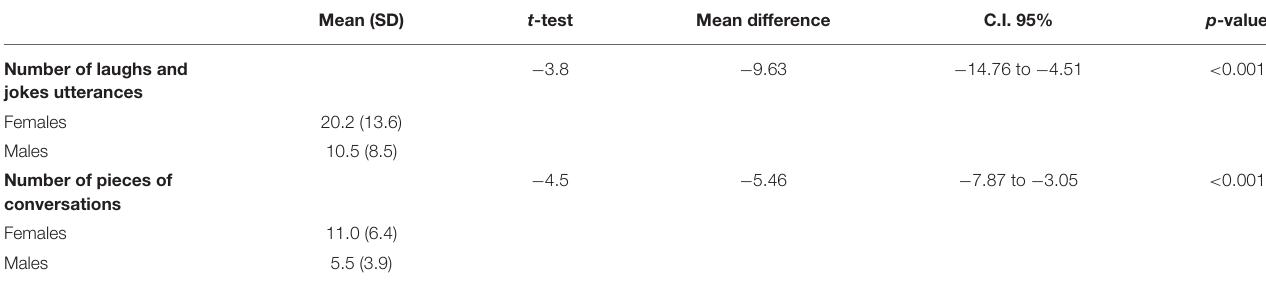
TABLE 2 | Quantitative analysis: association between physicians’ gender and laughs and jokes using t -test. Mean (SD) t -test Mean difference C.I. 95% p -value − 3.8 − 9.63 < 0.001 Number of laughs and jokes utterances Females 20.2 (13.6) Males 10.5 (8.5) Number of pieces of